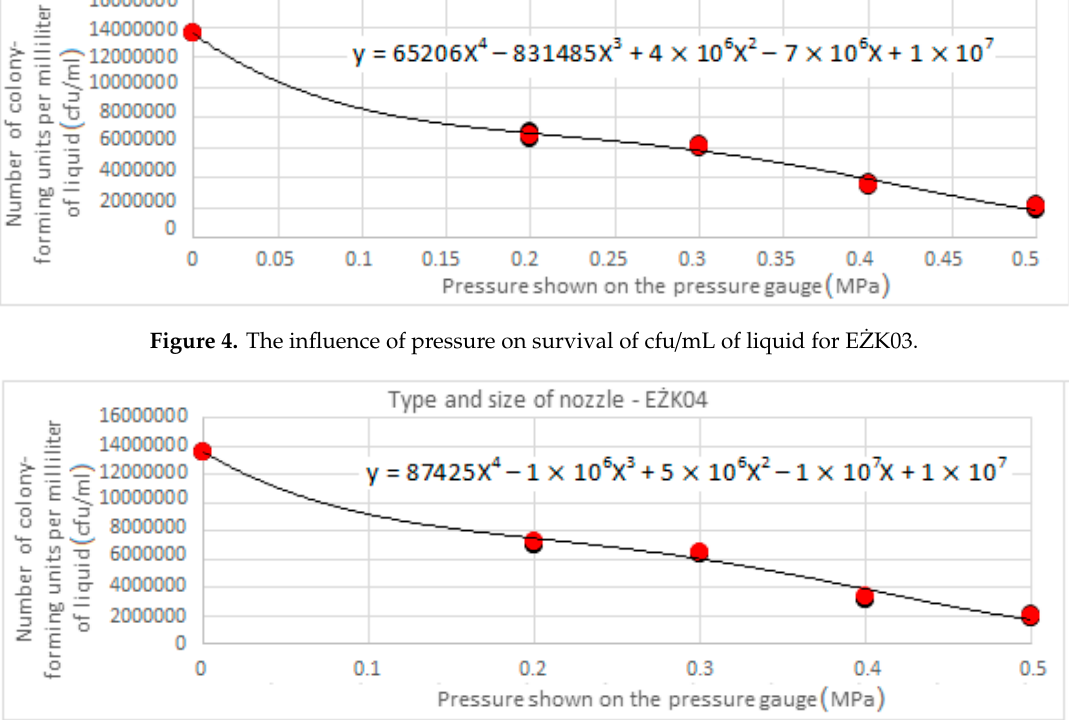
Figure 5. The influence of pressure on survival of cfu/mL of liquid for E Ż K04.